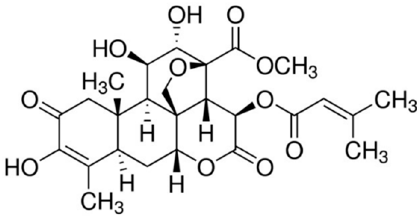
Figure 1. Chemical structures of brusatol.